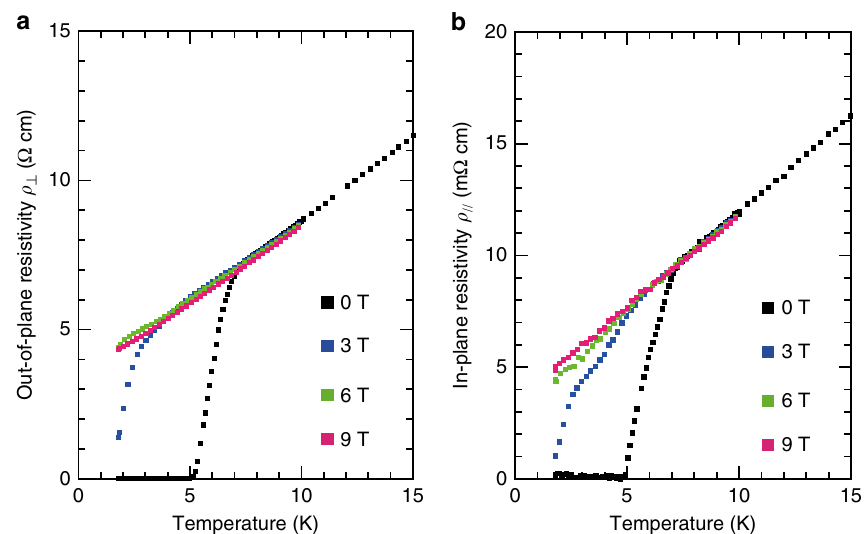
Fig. 5 Magnetic fi eld dependence of resistivity. a , b Out-of-plane resistivity ρ ⊥ ( a ) and in-plane resistivity ρ // ( b ) under magnetic fi elds of 0, 3, 6 and 9T applied perpendicular to the conducting plane at a pressure of 0.3